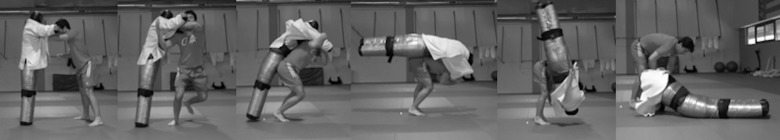
Ippon-seoi-nage sequence: 1) starting position; 2) beginning of the repetition; 3) off-balance; 4) loading the dummy onto the back, reaching the dummy’s horizontal position and leg extension; 5) dummy’s flight over the judoka; 6) end of the repetition.